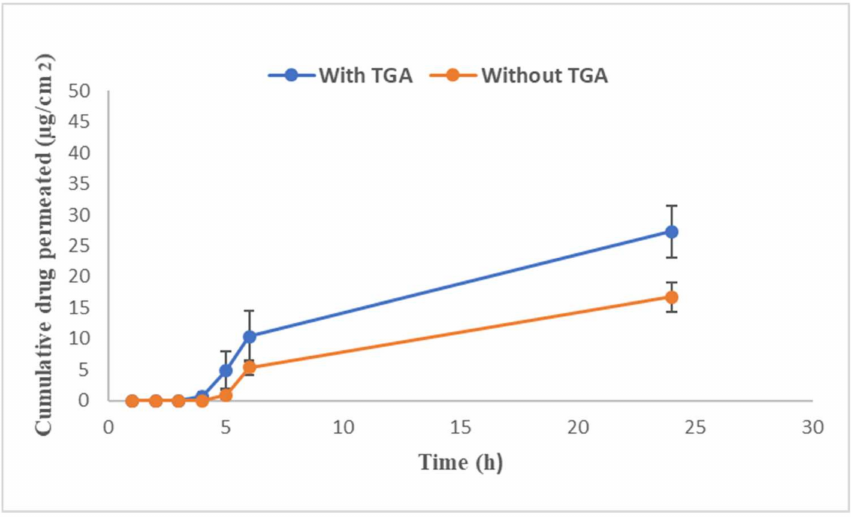
Figure 9. In vitro drug permeation across human